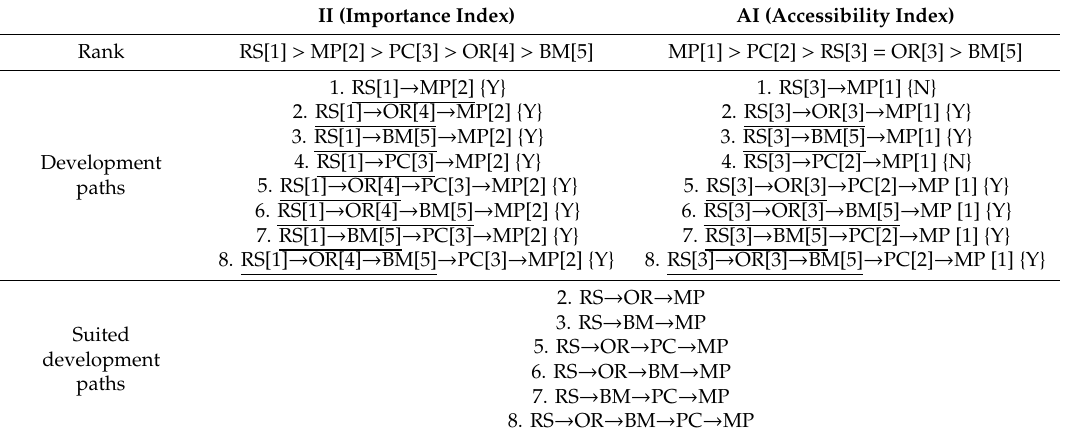
Table 18. The suited development paths for end